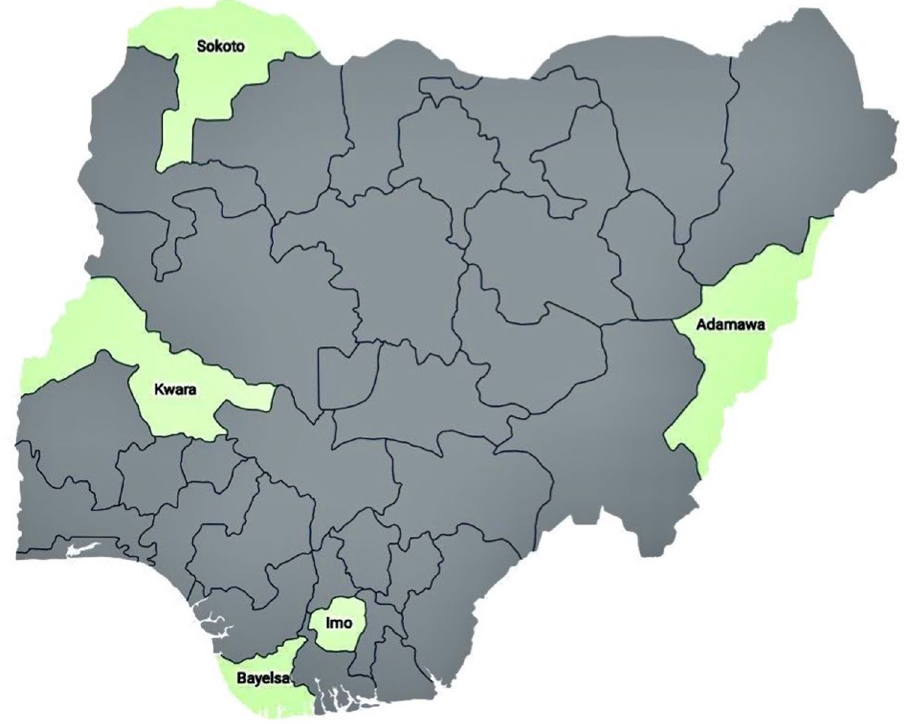
North-Central: Kwara, South-South: Bayelsa and South-East: Imo. (Map generated using Datawrapper: https :// www.dataw rappe